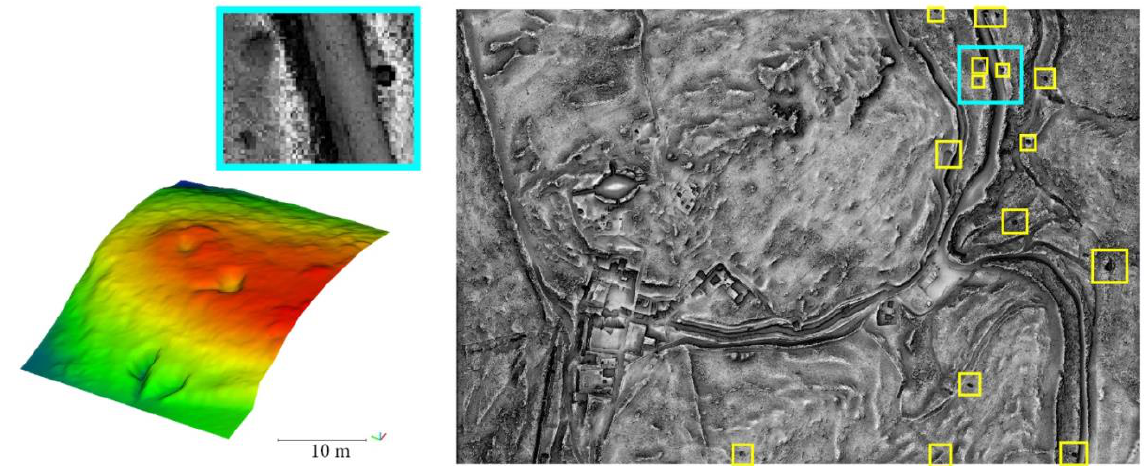
Figure 8. On the left, the 3D point cloud of a typical concave (excavated) mound. On the right, the raster DTM, visualised with an hillshaded filter to enhance the excavated mounds (in yellow brackets).